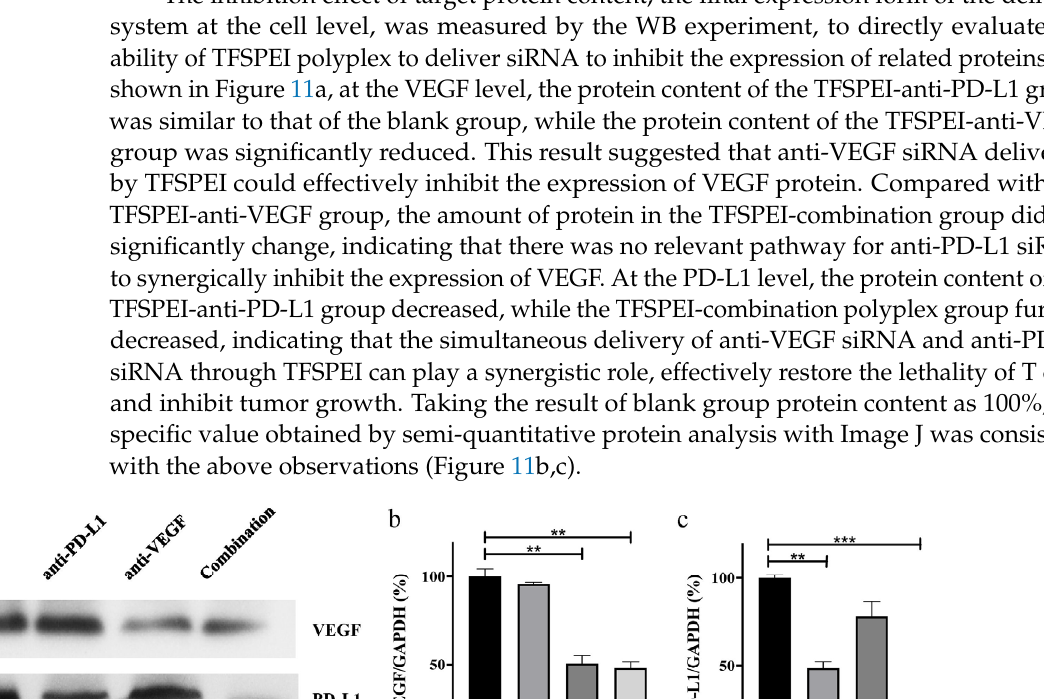
Figure 12. Evaluation of in vivo toxicity to main organs. H&E staining images of the main organs. Bars = 100 μ m.